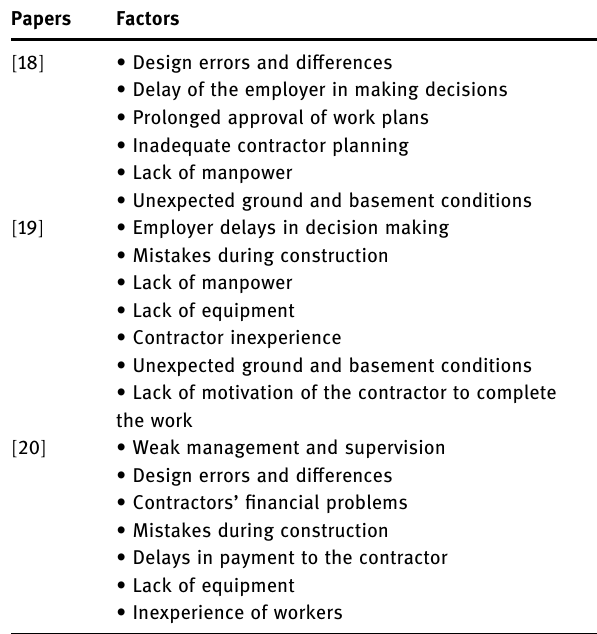
Table 1: Factors time delay factors